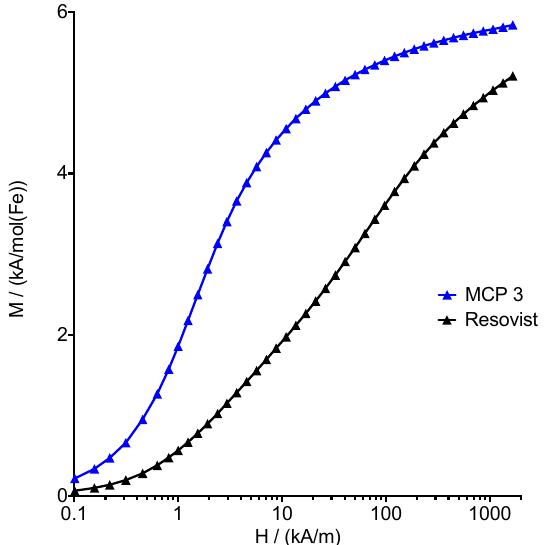
Figure 3. Molar magnetization M as a function of applied external field H measured for MCP 3 and Resovist ® at 295 K.